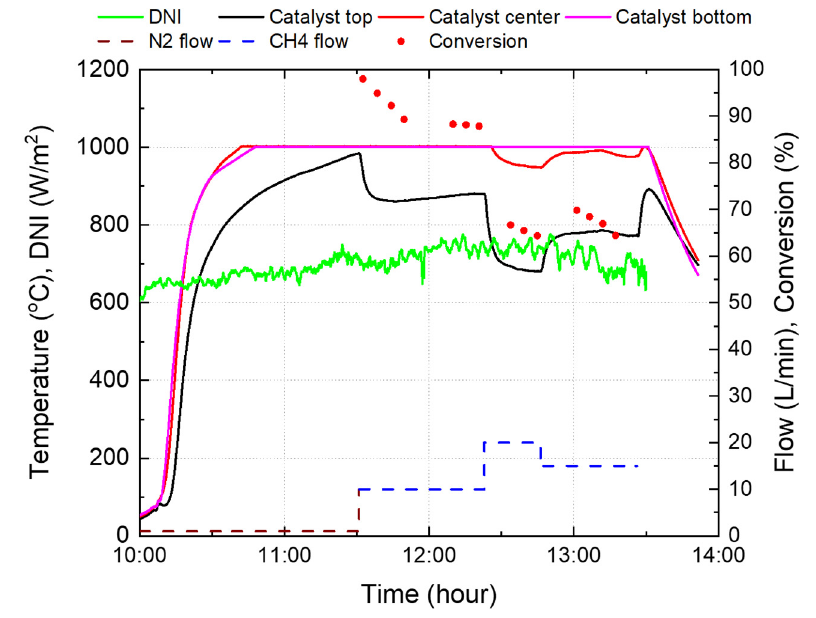
Figure 14. Experimental results using the reactor 1.